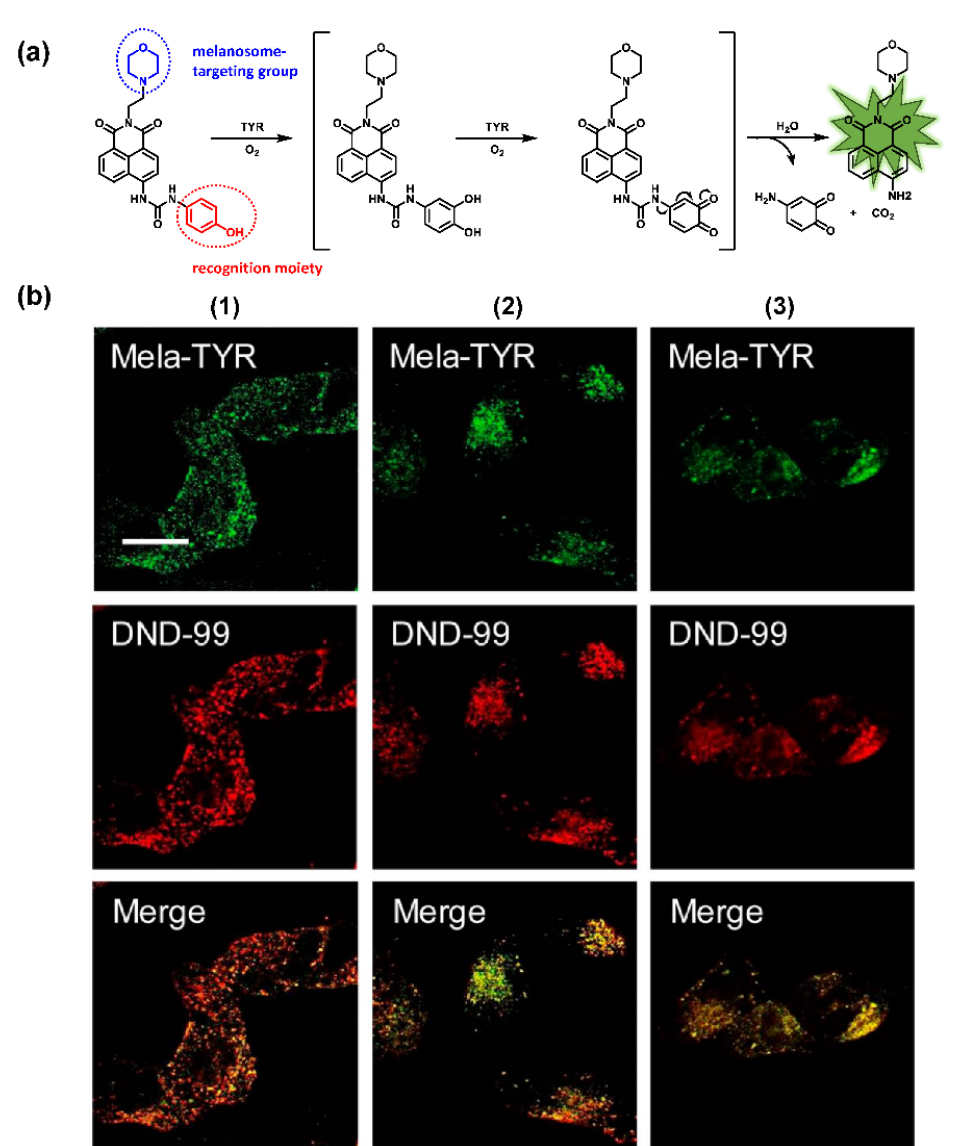
Figure 8. ( a ) The structure of Mela-TYR and its reaction mechanism with TYR. ( b ) Colocalization of Mela-TYR and lysosome tracker DND-99 in B16 cells. The cells were pretreated with inulavosin (10 µ M) for (1) 0, (2) 6, and (3) 12 h, respectively, and then incubated with Mela-TYR and DND-99 [89]. Copyright permission is granted by American Chemical Society.